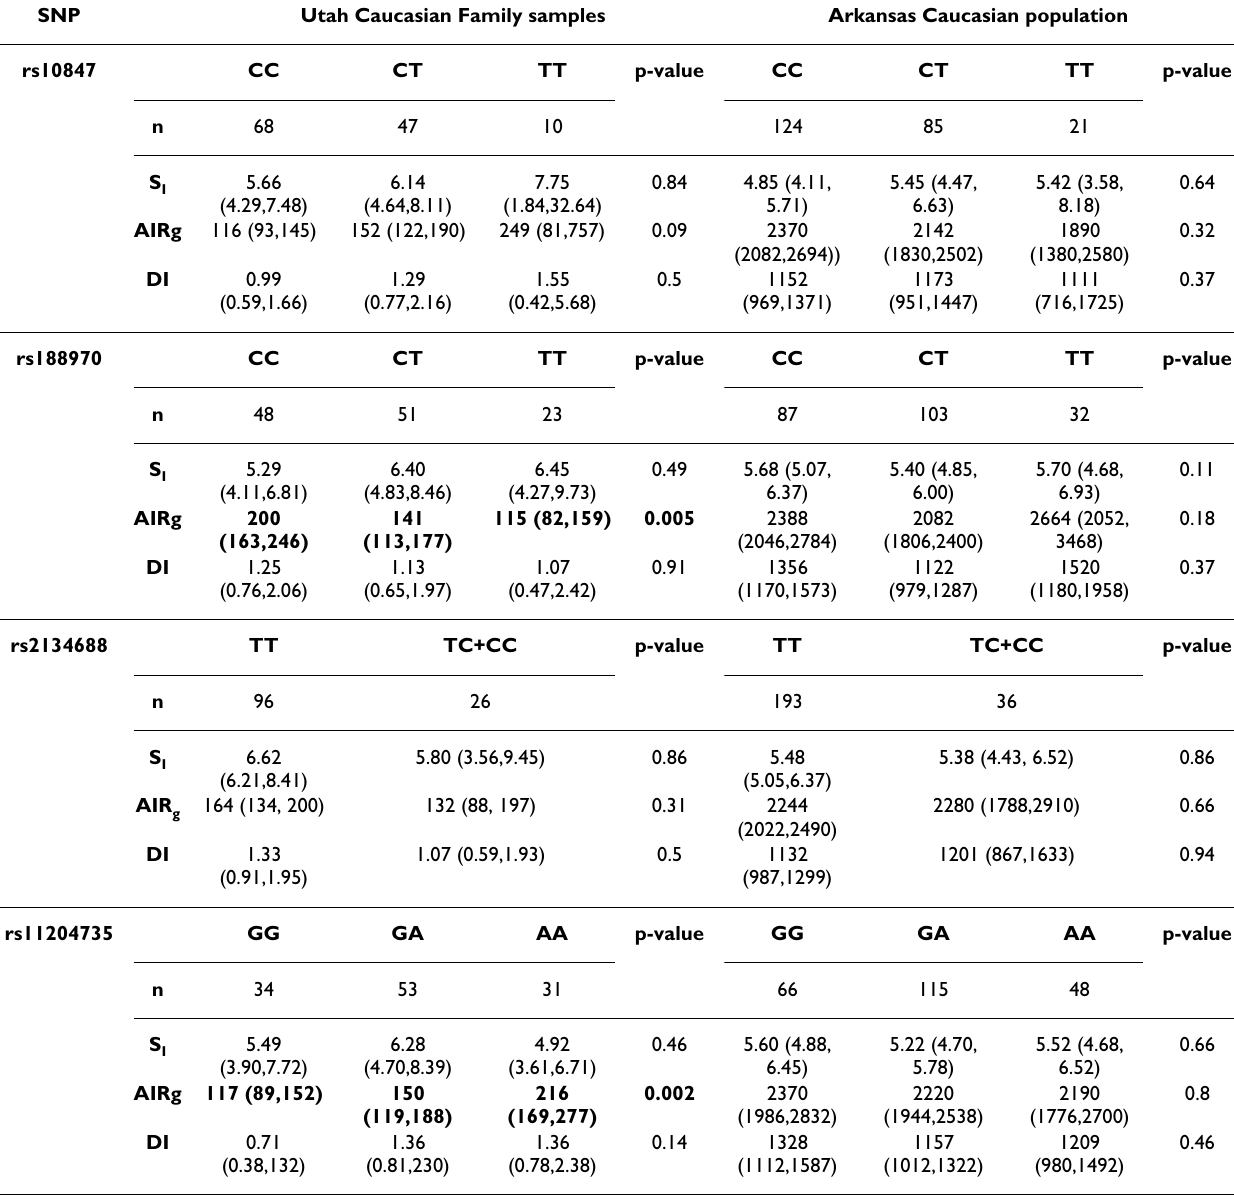
Table 6: Marginal means for intravenous glucose tolerance measures SNP Utah Caucasian Family samples Arkansas Caucasian population